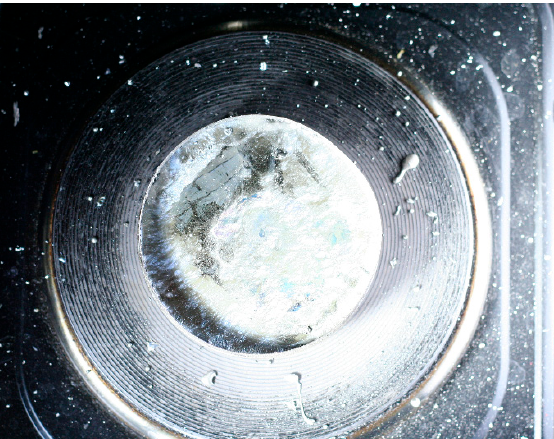
Figure 10. After-test photo of the heater and vessel with scattered frozen melt particles. Table 4. Best-fit approximation parameters (see Equation (1)).